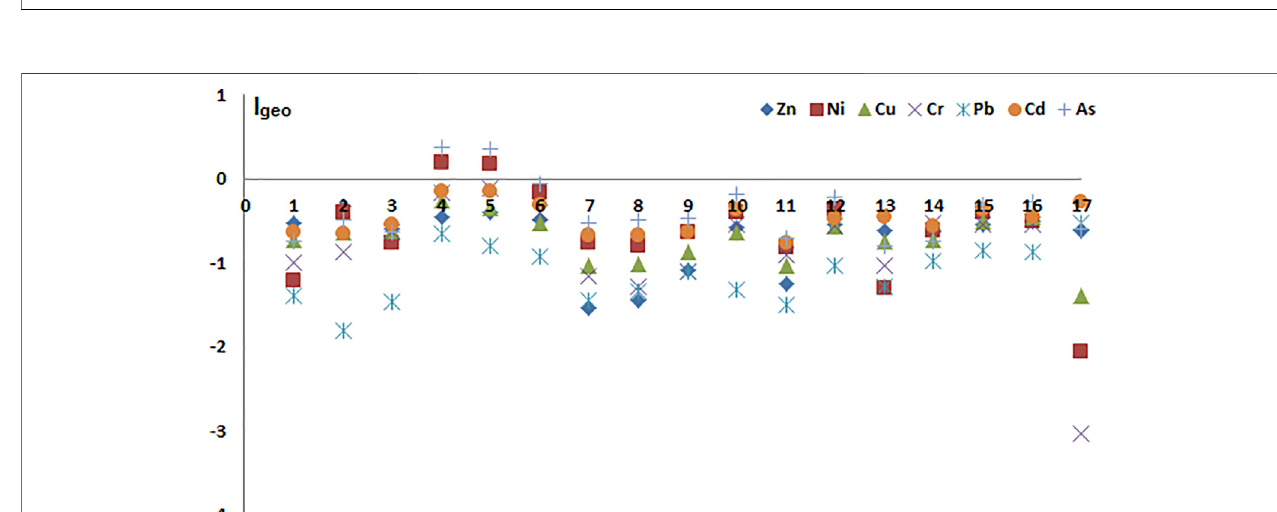
FIGURE 6 | Distribution of studied elements enrichment based on I geo in sediment: 1 — Vlasina (before receiving any tributary); 2 — Gradska river (before its con fl uence with Vlasina); 3 — Vlasina (upstream of the con fl uence with Tego š ni č ka river); 4 — Tego š ni č ka river (stone pit); 5 — Tego š ni č ka river (near village Dobrovi š ); 6 — Vlasina (downstream of the con fl uence with Tego š ni č ka river, near village Gornji Orah); 7 — Ljubera đ a (middle course); 8 — Ljubera đ a (measuring pro fi le); 9 — Ljubera đ a, (con fl uence with Vlasina); 10 — Vlasina (after receiving Ljubera đ a); 11 — Pusta river; 12 — Vlasina (downstream of the con fl uence with Pusta